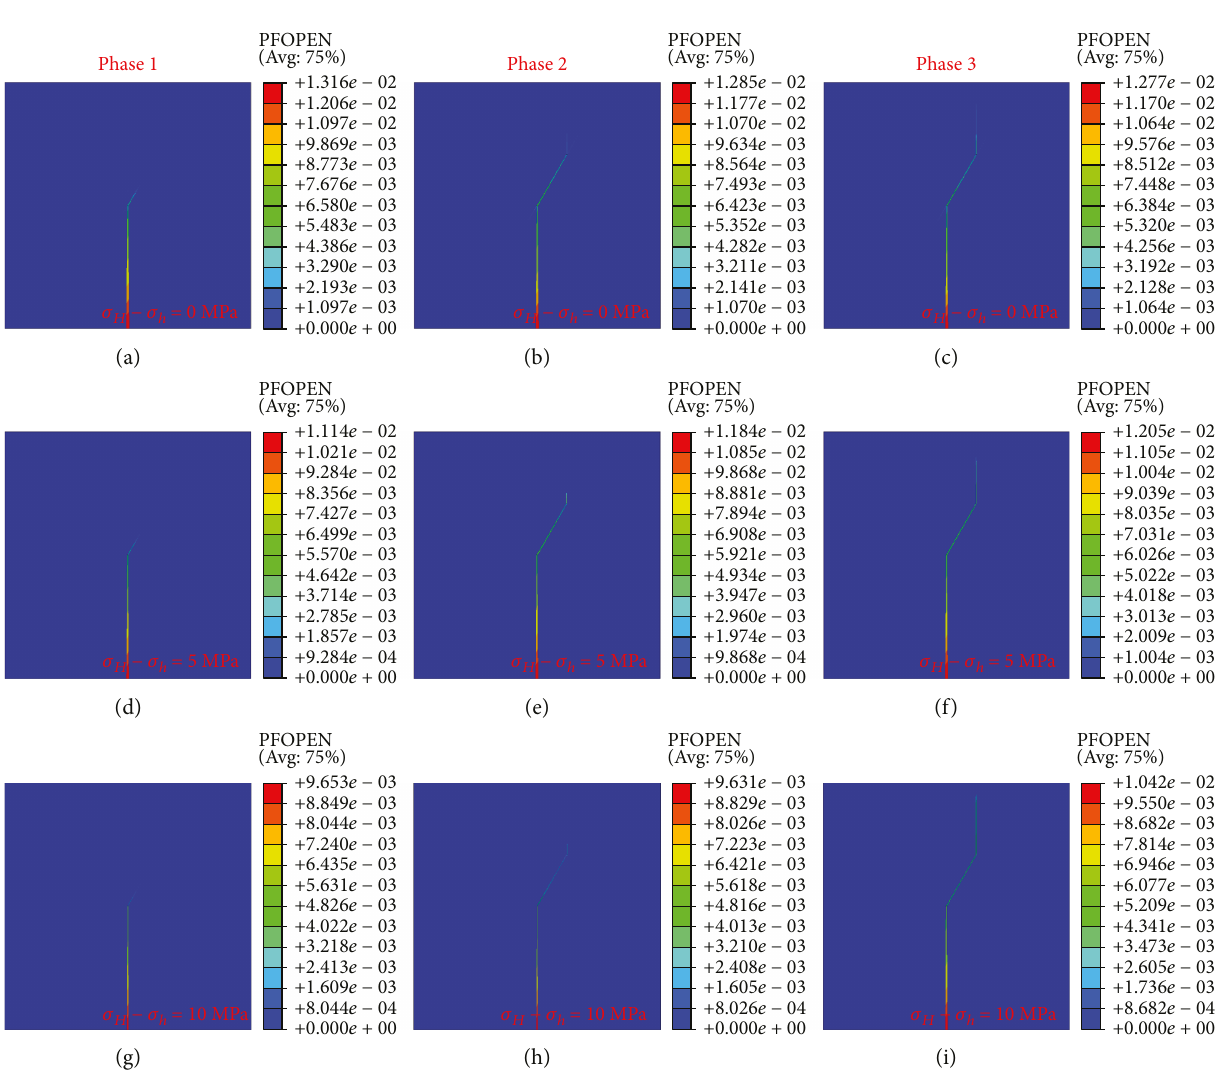
Figure 7: Approaching angle of 30 °